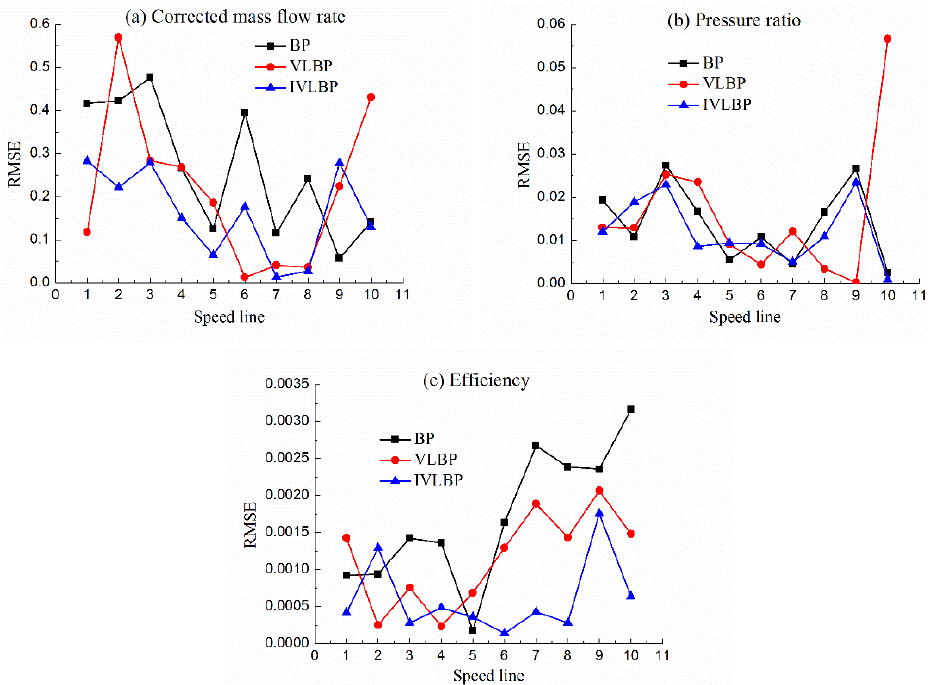
Figure 10. The predicted RMSE based on the three algorithms.